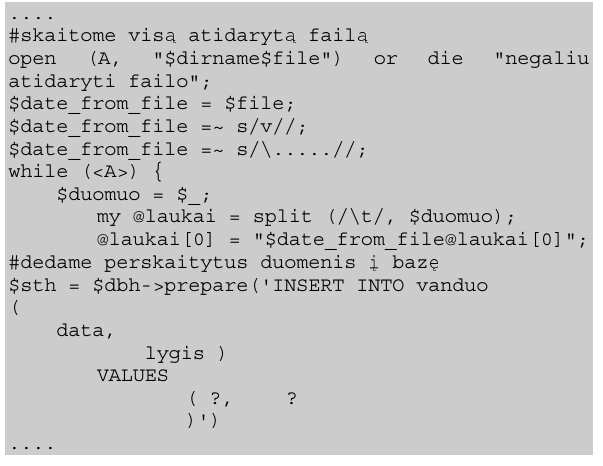
Fig 5 . Fragment of Perl script for water level measurements transfer to database